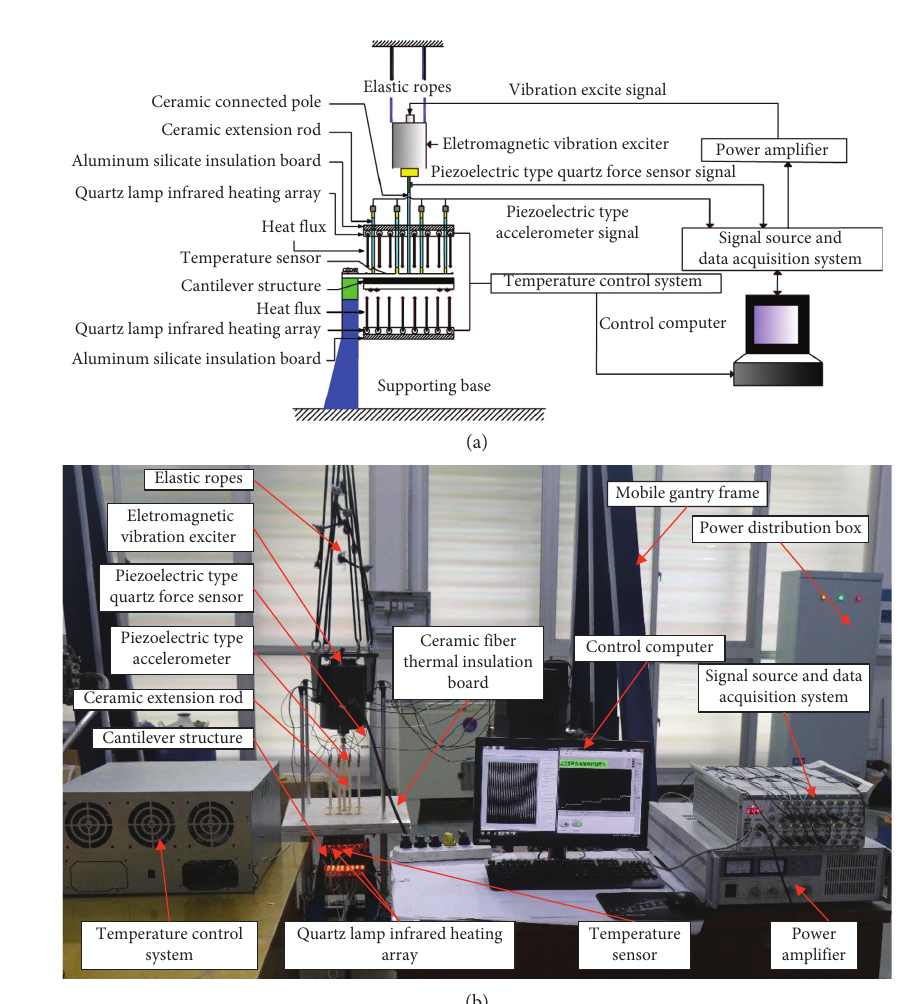
Figure 9: Thermal-vibration joint test system. (a) Schematic of the experimental modal test system. (b) Photograph of the thermal/vibration joint test.